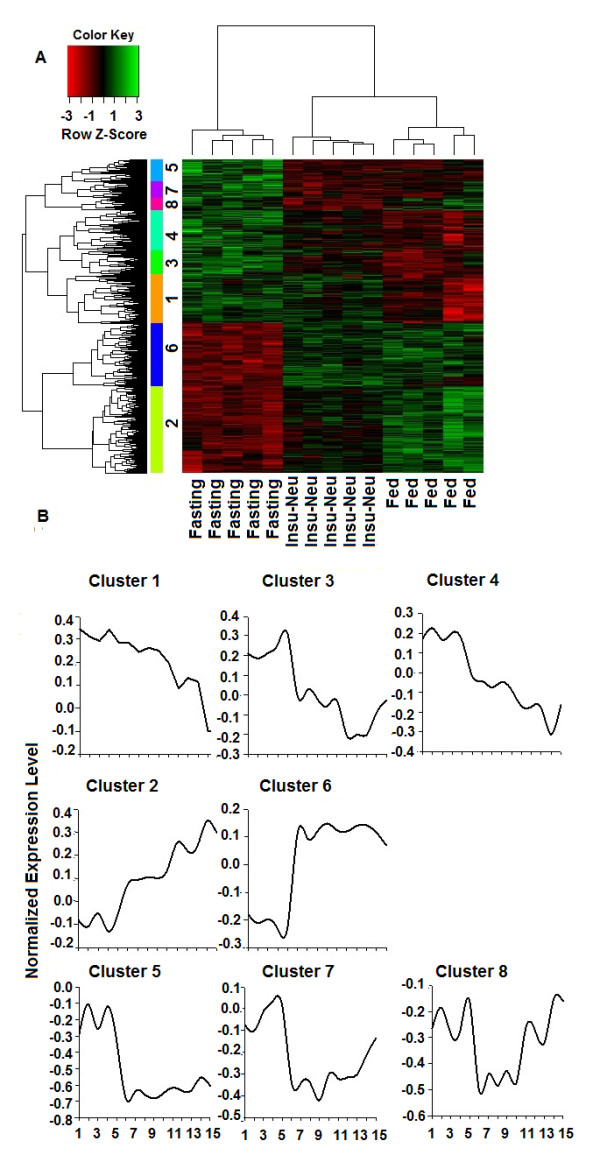
Cluster analysis of differentially expressed genes. The 2016 genes differentially expressed in one or both treatment groups vs. fed controls were subjected to hierarchical clustering to visualize similarities and differences between treatment groups. (A). Hierarchical cluster analysis of the 2016 genes (FDR adjusted p-value <0.05) that were differentially expressed between insulin-neutralized vs. fed and/or fasted vs. fed states. (B) Seven clusters (numbers) representing the most distinct effects of treatment were selected to further analyze expression profiles across treatments. Sample ID number on the X-axis corresponds to treatment group: sample 1–5, fasted; 6–10, insulin neutralized; 11–15,fed control. Y-axis represents relative gene expression value.